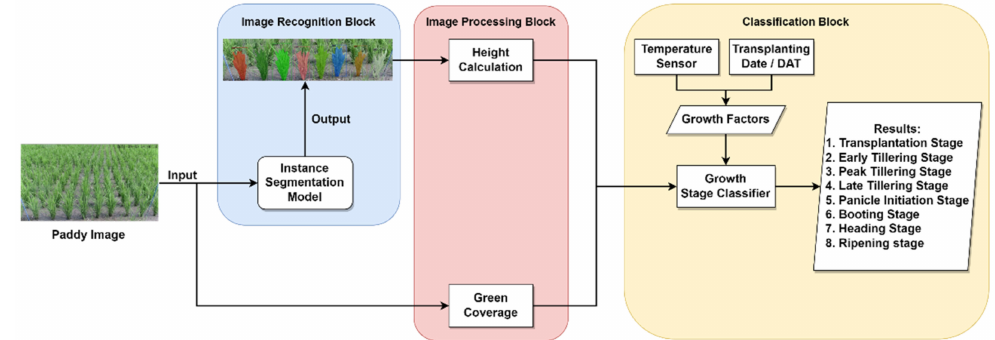
Figure 4. The system Architecture for the Paddy Rice Growth Stage